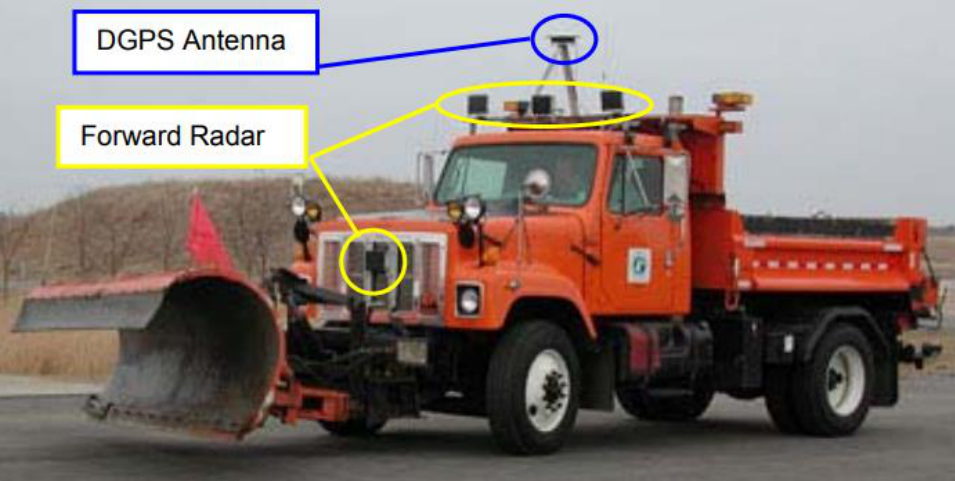
Figure 4. Snowplow equipped with driver assistive system (DAS) technologies at MnROAD [37].